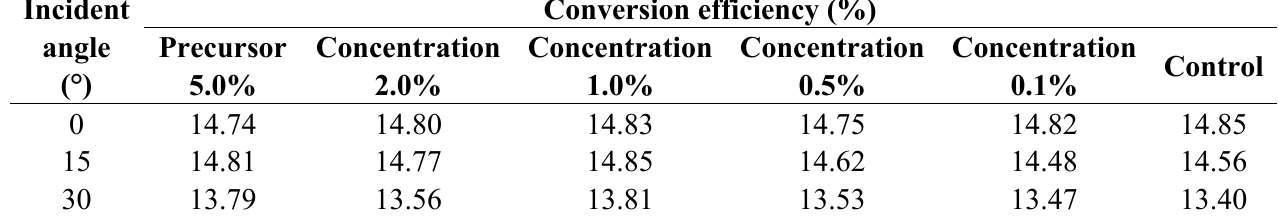
Table 1. The incident angle dependency results on solar cell conversion efficiency for all the coated and control (non-coated) cell samples. The precursor concentration ranged from 0.1% to